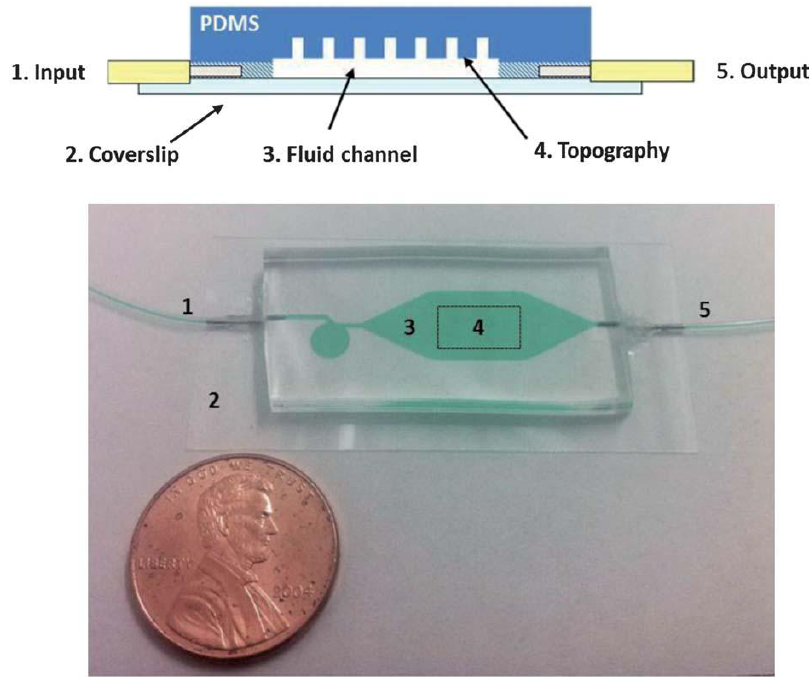
Figure 3. Microfluidic device used for bacterial surface attachment studies under dynamic fluid flow conditions (from Graham et al . [73], reproduced by permission of The Royal Society of